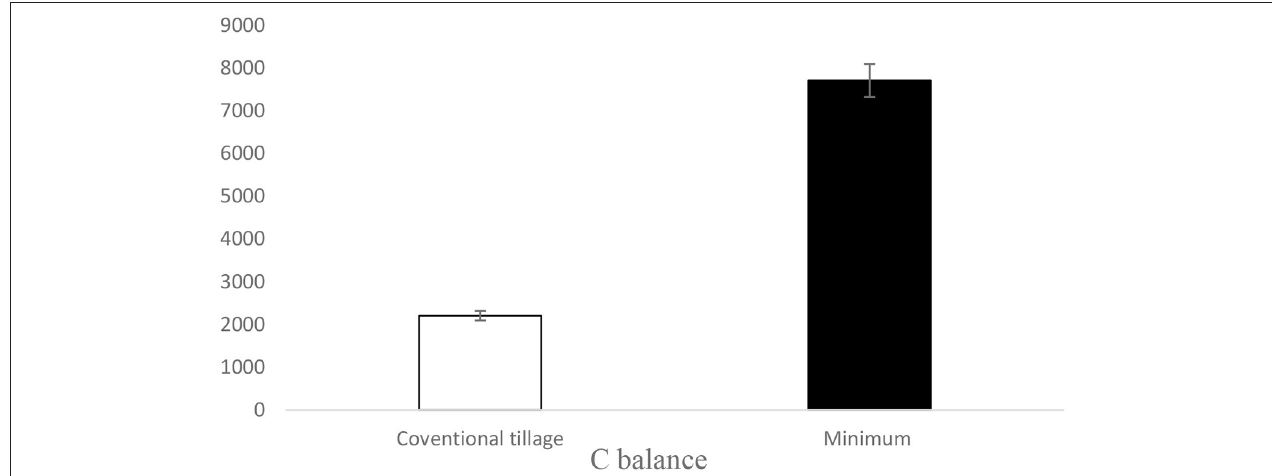
FIGURE 7 | Integration of trees and shrubs into cropping systems for facilitation of resource use and crop productivity. Source: adopted from Malézieux et al. (2009).